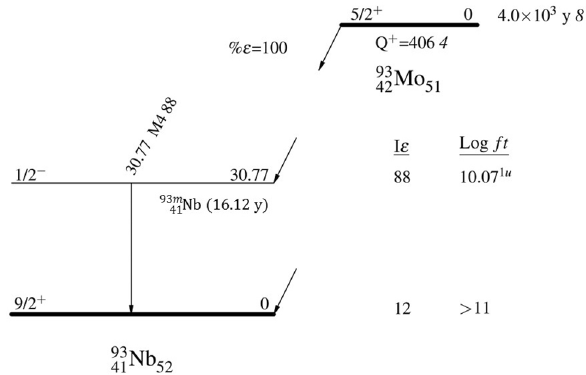
Figure 1. Evaluated decay scheme of 93 Mo from 5 . Reprinted from Nuclear Data Sheets, 112/5, Coral M. Baglin, Nuclear Data Sheets for A = 93, 1163–1389, Copyright (2011), with permissionn from